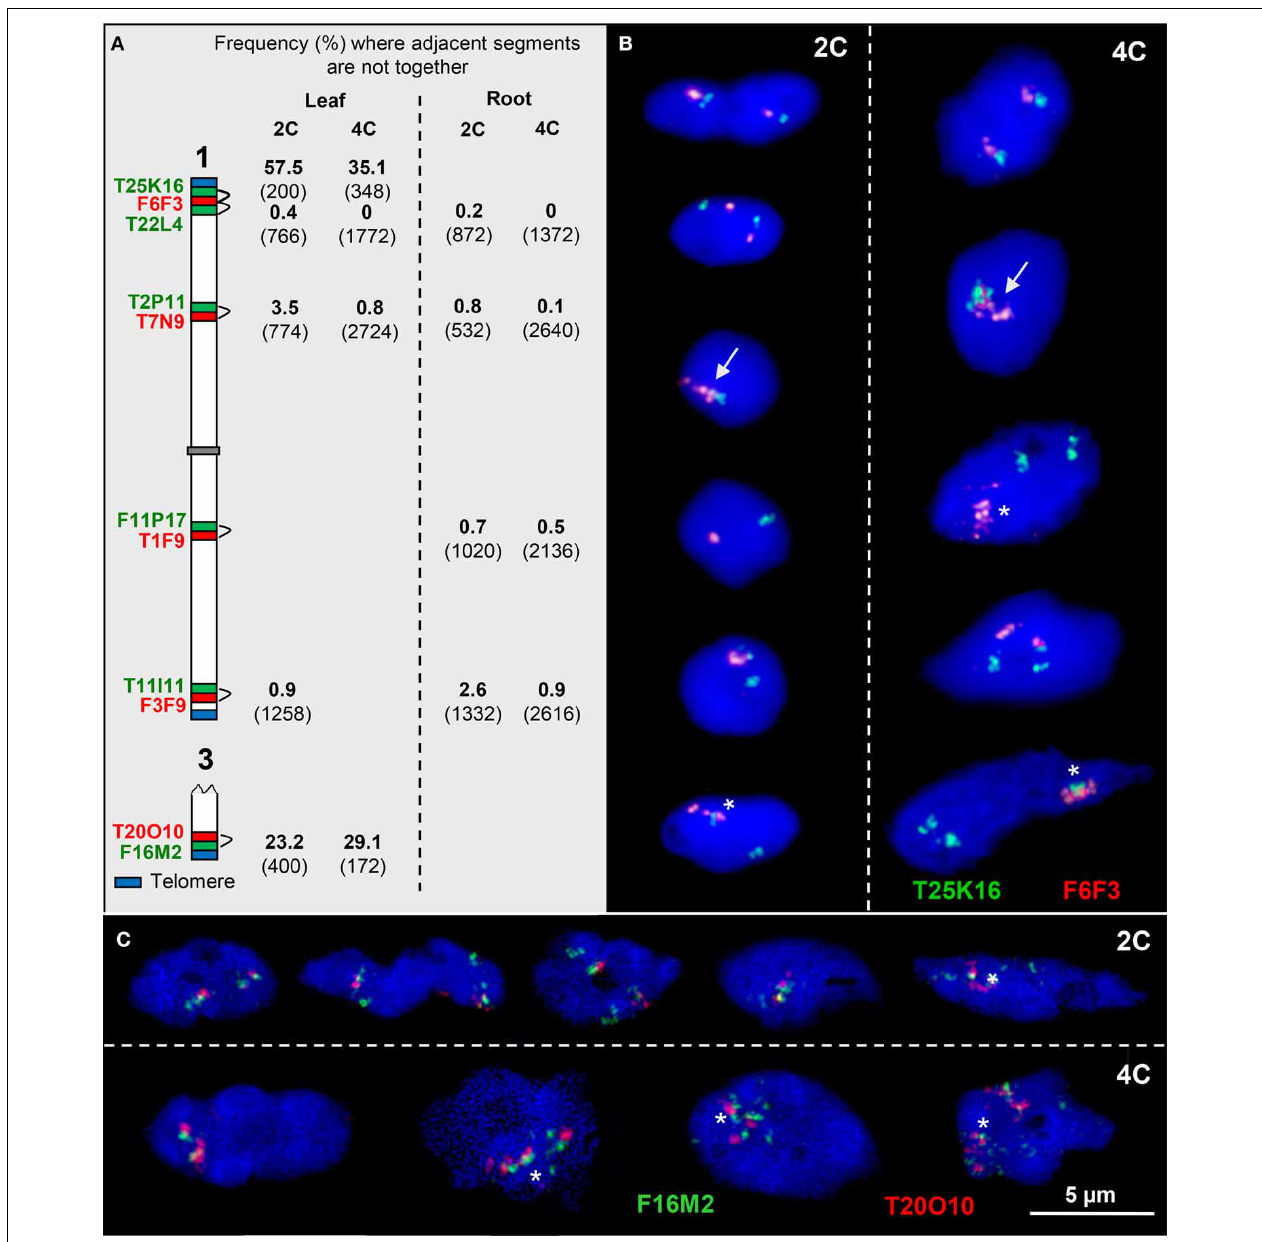
FIGURE 4 | Configurations of adjacent euchromatin segments. (A) Scheme of chromosomes 1 and 3 showing the subtelomeric and interstitial position of adjacent segments (probed by two BACs in different colors). The percentage of nuclei where the adjacent segments were found not close together in 2C and 4C leaf and root nuclei, respectively, is indicated (number of investigated homologs (2C) and of sister chromatids (4C) in parentheses). (B) The top 2C and 4C nuclei